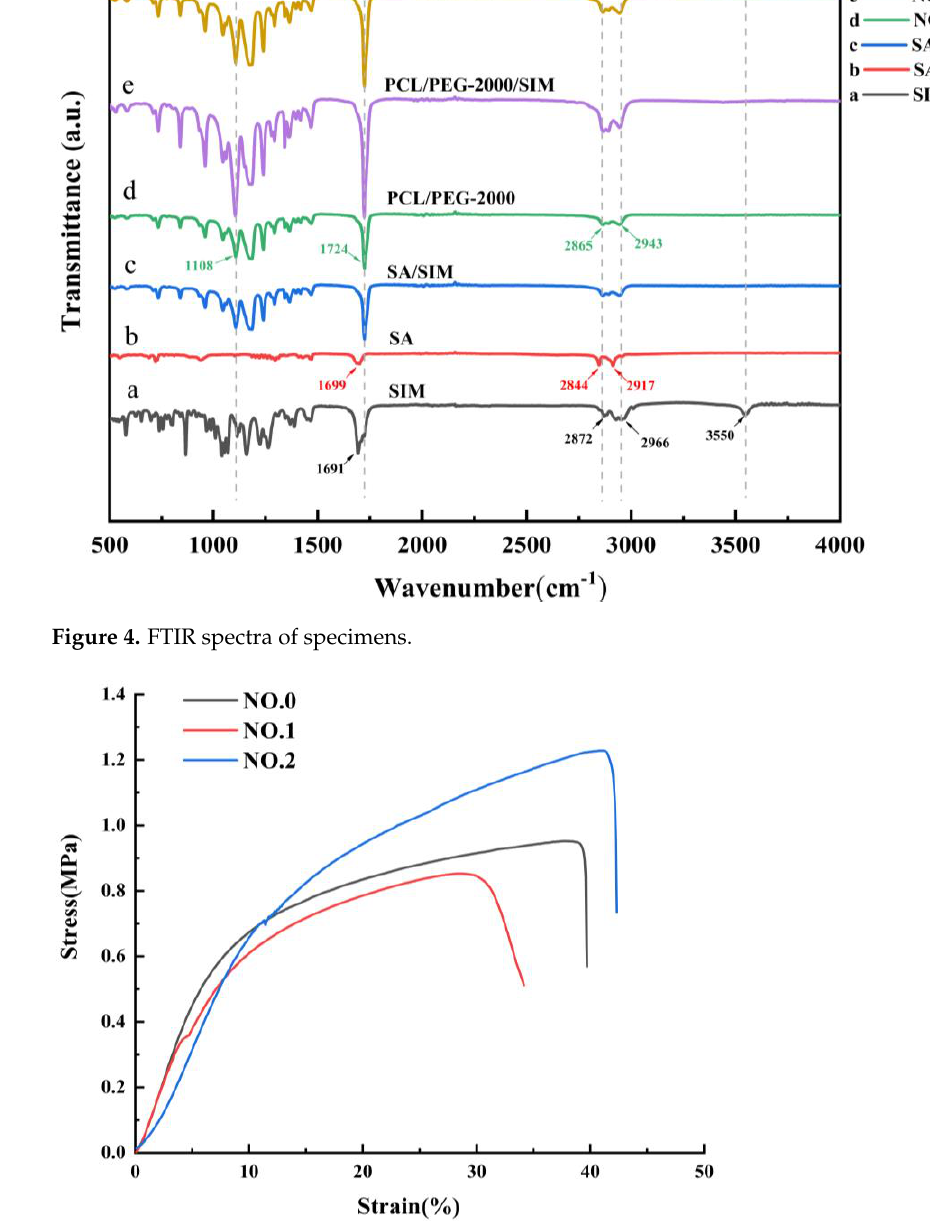
Figure 5. Mechanical properties of NFMs: stress-strain curve. Table 3. Tensile properties of NFMs.